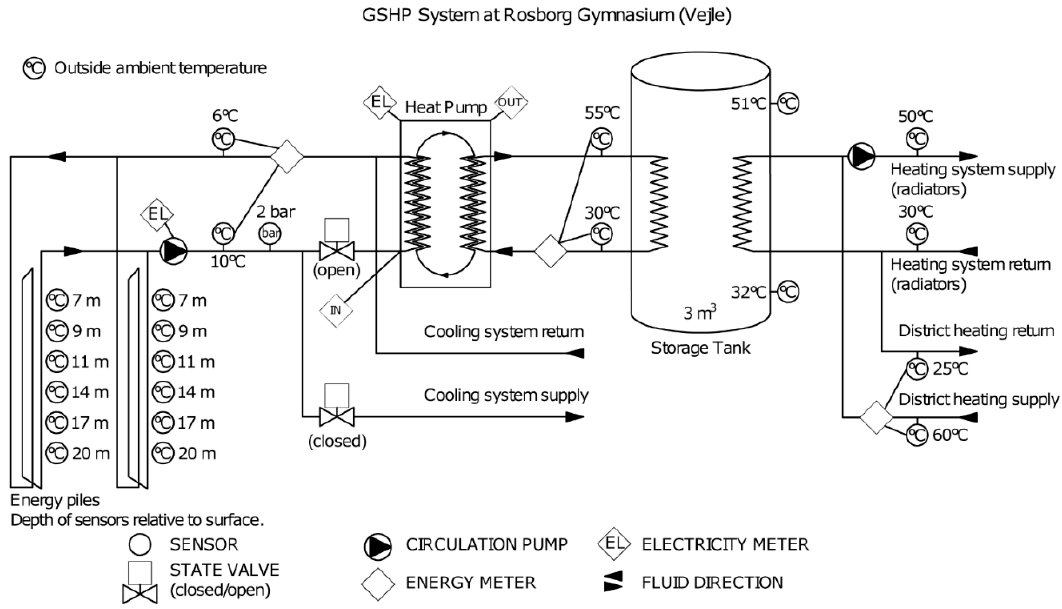
Figure 4. The GSHP system at Rosborg Gymnasium (Vejle, Denmark).